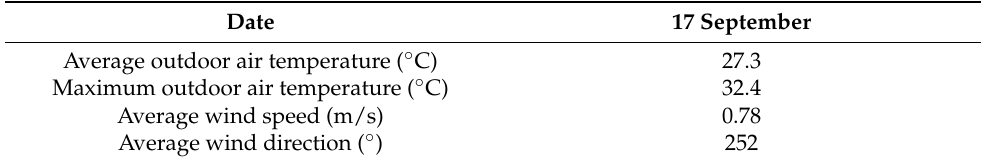
Figure 4. Air temperature variations and temperature differences of two vehicles on 17 September. Table 3. Ambient conditions on 17